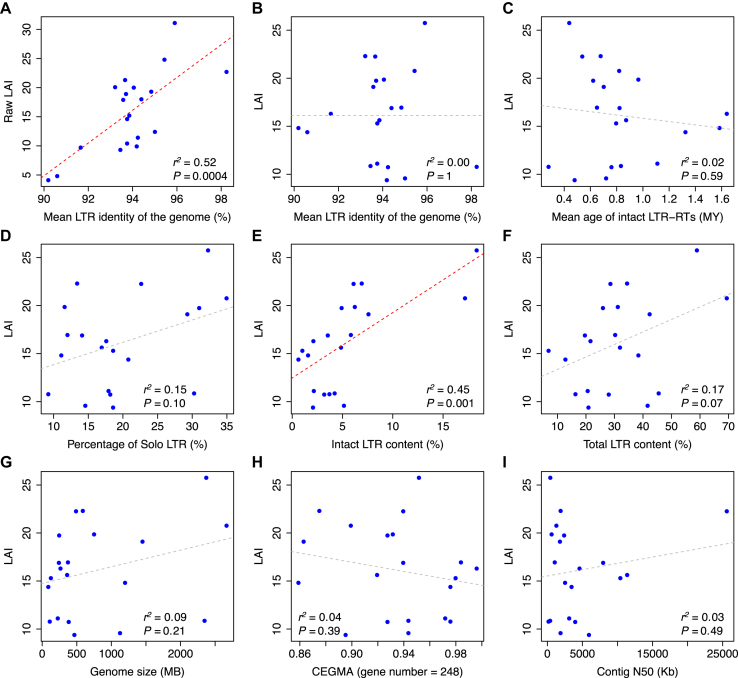
Characterization and correction of the LTR Assembly Index (LAI) using 20 high-quality plant genomes. (A) The raw LAI is linearly correlated with the mean LTR identity of the genome. The LAI adjusted based on the mean LTR identity is independent of (B) the mean LTR identity of the genome, (C) the mean age of intact LTR-RTs, (D) the percentage of solo LTR among all LTR sequences, (F) total LTR-RT content, (G) haploid genome size, (H) CEGMA gene set completeness, and (I) contig N50. (E) LAI is linearly correlated with intact LTR-RT content. Each blue dot represents one species. The coefficient of determination (r2) and F-test P value between x- and y-axis are indicated on each plot. Significant and non-significant linear regressions are indicated in red- and gray- dotted lines, respectively.